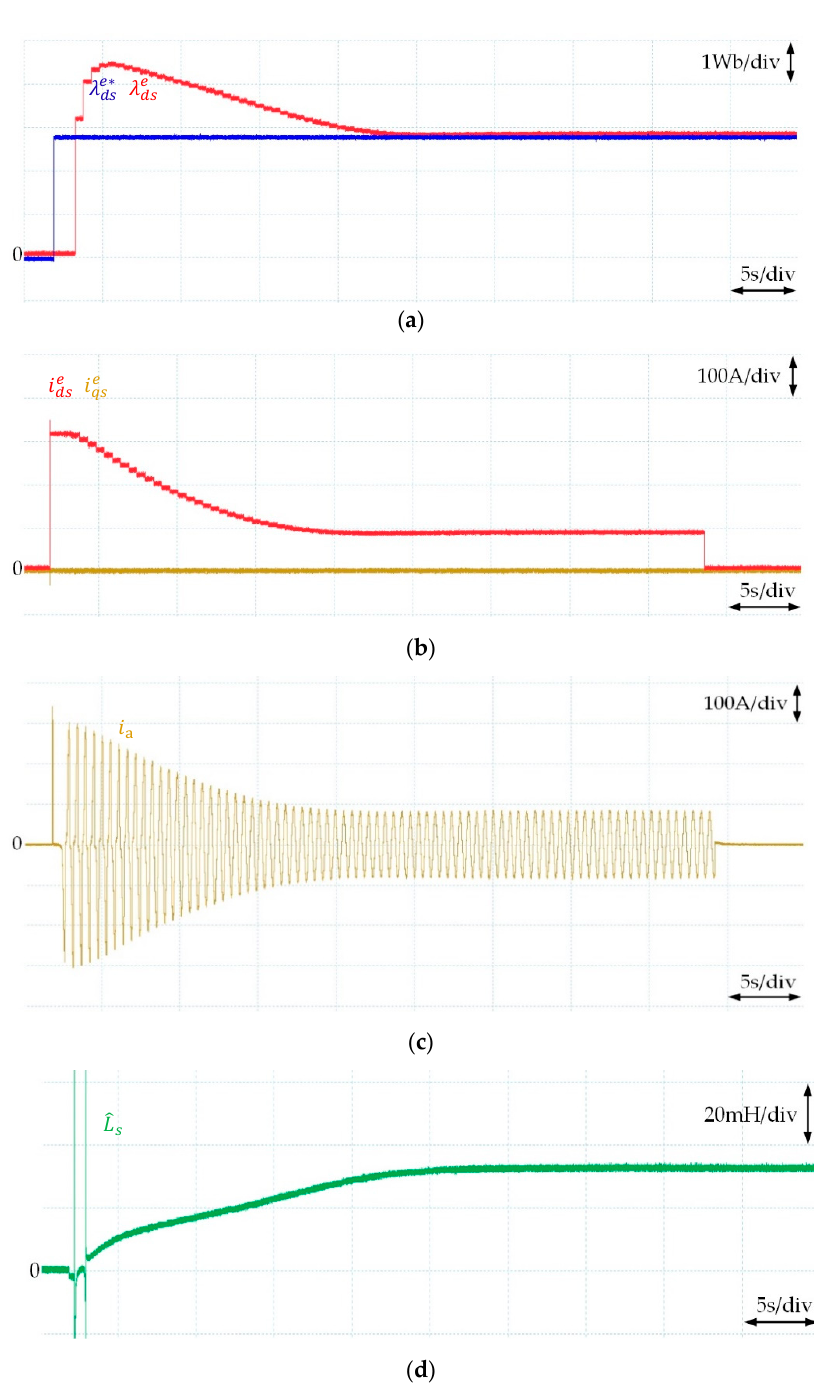
Figure 12. Experimental results for the second motor (500 kW/1140 V); ( a ) reference and estimated stator flux, ( b ) dq -axis reference and measured currents in a rotating reference frame, ( c ) a-phase current, ( d ) identified stator inductance.